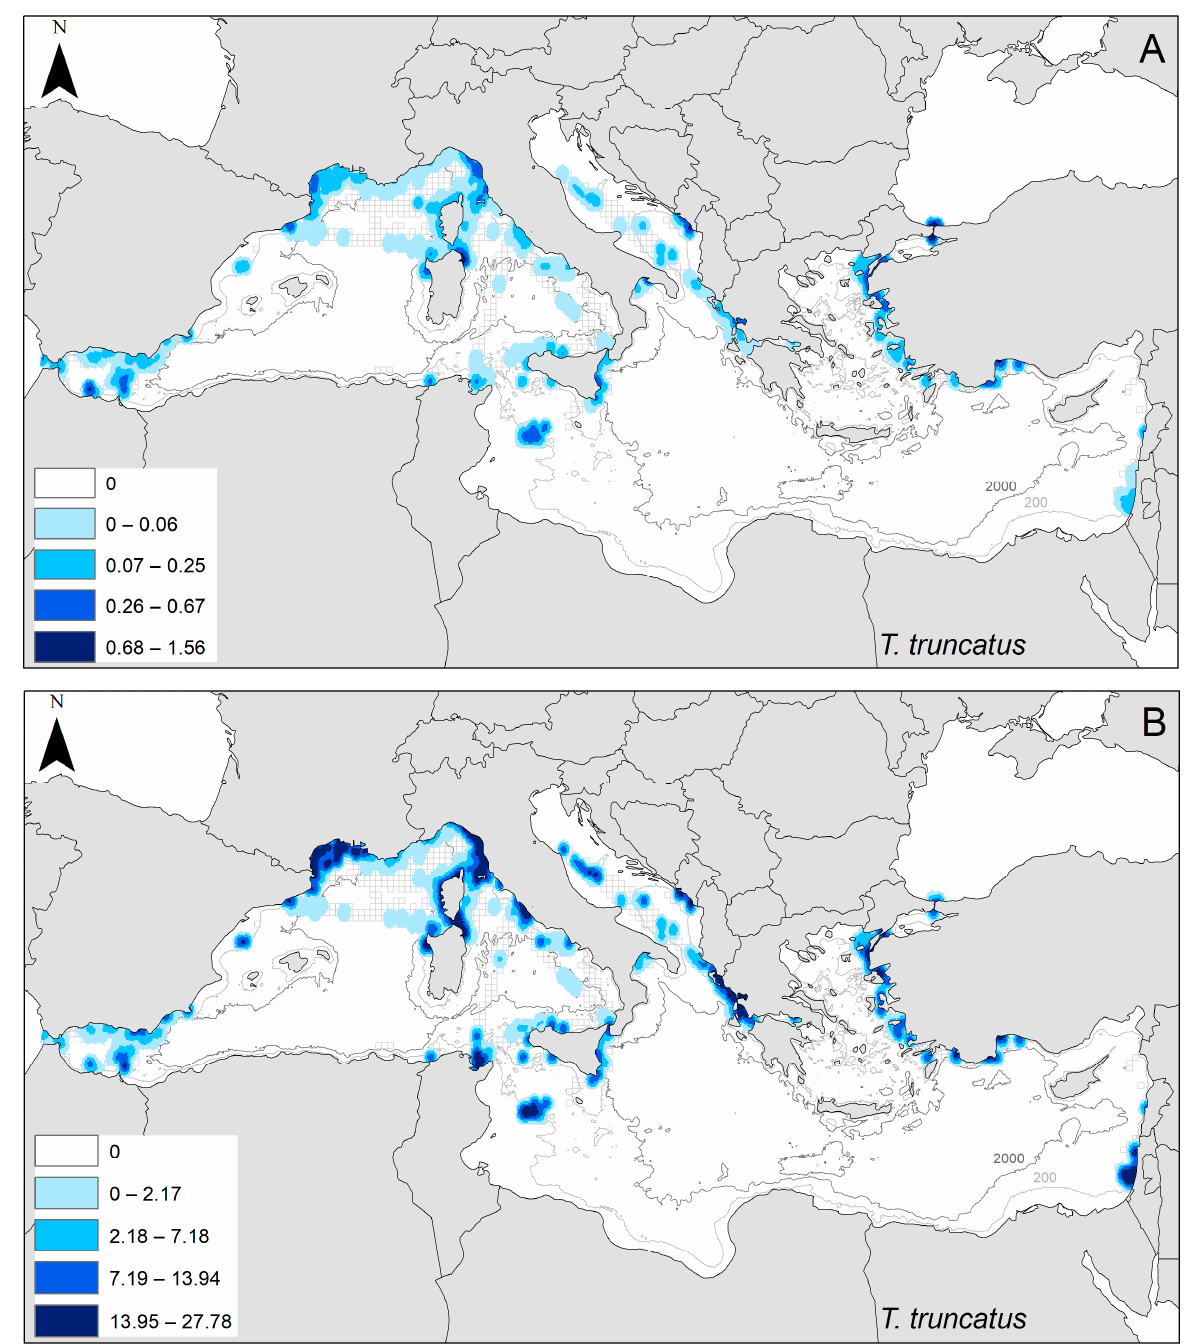
close to the coastline and in semi-closed contexts, provided there was the right water depth (such as in the Gulf of Corinth, Greece). Its ER is higher in the western basin, specifically in the Alboran Sea and in the north-western Mediterranean. The striped dolphin shows a high prevalence in most of the sampled offshore waters ( B ), confirming its status as a dominant species of the offshore do- mains. However, in the Alboran Sea, its prevalence is relatively low (despite the high ER), probably due to the coexistence of other species (Kernel density parameters: cell size x, y = 5 × 5 km; radius ≈ 30 km; criterion for division into classes: natural breaks).